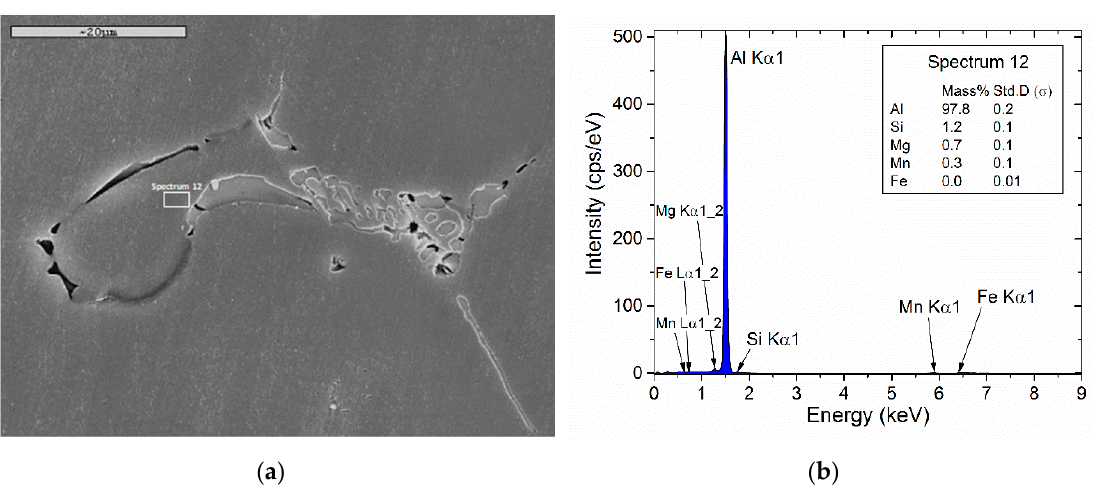
Figure 4. ( a ) SEM micrograph of the as-cast microstructure of alloy 6082, ( b ) EDS analysis of region adjacent to the boundary, indicated by a square in (a). Table 3. Fractions of phases and matrix composition close to the boundary in as-cast 6082.